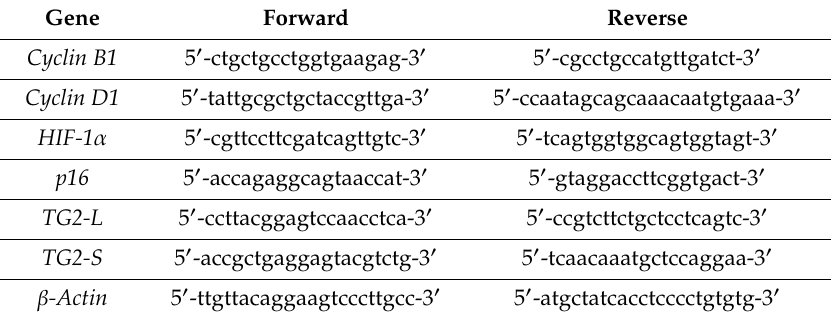
Table 1. Primer sequences used for Real-Time